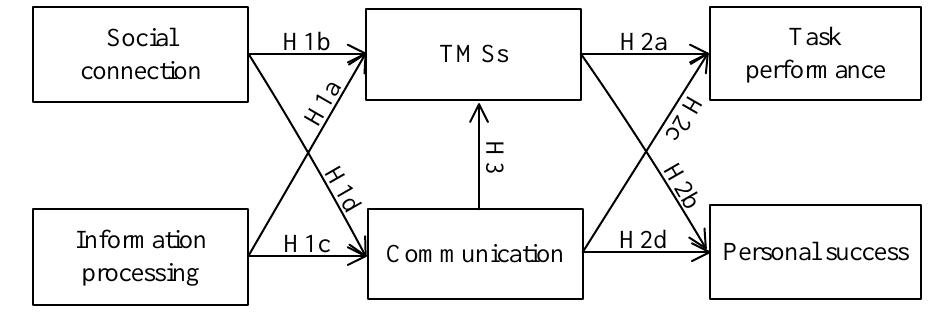
Figure 1. Research model and